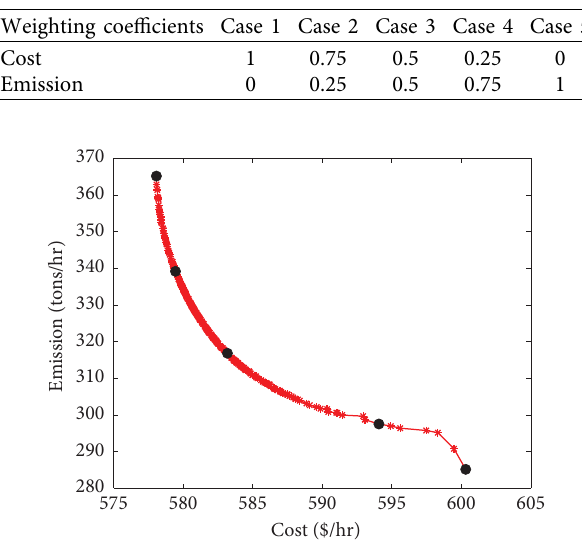
Table 9: Weighting coefcients of objective functions for group B.